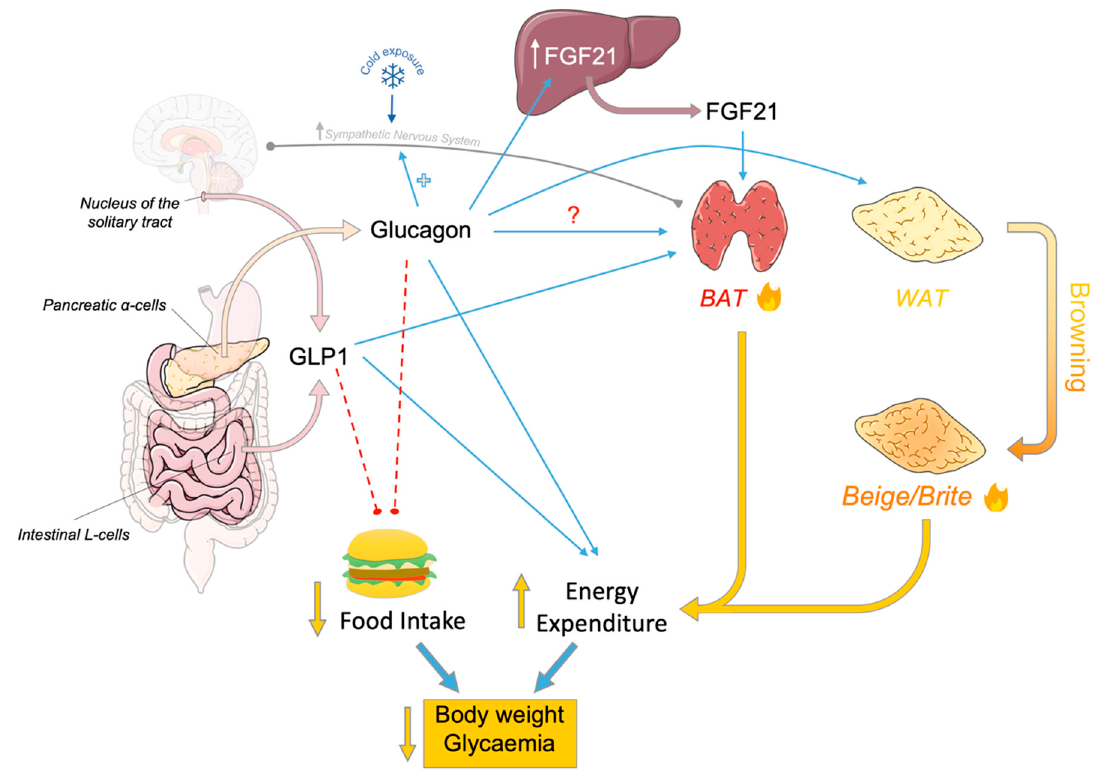
Figure 1. L cells from the digestive tract and nucleus of the solitary tract release glucagon-like peptide-1 (GLP-1) which inhibits feeding, as well as favors thermogenesis in brown adipose tissue (BAT) leading to augmented energy expenditure. Pancreatic alpha-cells release glucagon that apparently stimulates thermogenesis in BAT through favoring cold acclimation and also fibroblast grow factor 21 (FGF21) release in the liver which acts activating thermogenic process in BAT. Furthermore, glucagon may directly stimulate BAT and browning of white adipose tissue (WAT). GLP-1-dependent inhibition of food intake and glucagon-dependent augmentation of energy expenditure have demonstrated beneficial effects on type II diabetes and obese patients leading to reduction of body weight, glycaemia and other metabolic disorders. Direct positive effect (blue arrows), direct negative effect (red dashed lines) and sympathetic efferent projection (grey line). Figure made with Servier Medical Art resources.